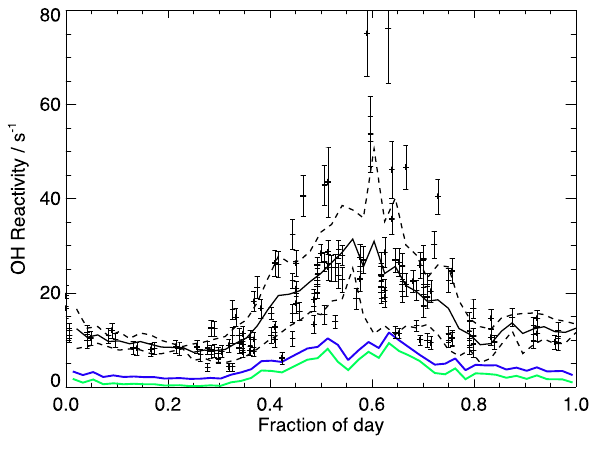
Figure 4: OH reactivity observations (black markers), filtered for when supporting observations of major OH sinks were available, plotted against fraction of local day, with error bars indicating +/- 1 sigma uncertainty on each observation. The solid black line is the mean diurnal, averaged into 30 min time bins, with the dashed lines indicating +/- 1 standard deviation. The blue line shows the calculated OH reactivity from the supporting observations of OH sinks shown in Fig. 6. The green line is the calculated OH reactivity from reaction with only the observed isoprene. Figure 5 is the observed OH reactivity data plotted against the OH reactivity calculated for isoprene alone (i.e. the OH + isoprene rate constant multiplied by the observed isoprene concentration at each point). Although the data shown in Fig. 5 exhibit a large degree of variability, likely due to observed variations in the mix of primary BVOC and secondary compounds contributing to OH reactions as well as the influence of different meteorological conditions, it does have some correlation (r 2 = 0.5). The best fit gradient of this plot (2 +/- 0.2) gives the average number of OH radicals lost per isoprene molecule, and despite the observed variability in the data is significantly higher than the gradient calculated from the observed compounds which react with OH (1.1 +/- 0.01). The small increase in the gradient calculated from the observations above unity reflects the correlation in the diurnal profiles of the BVOCs, i.e. the similarity in the observed diurnal trends of isoprene and monoterpenes which can be seen Fig. 1.